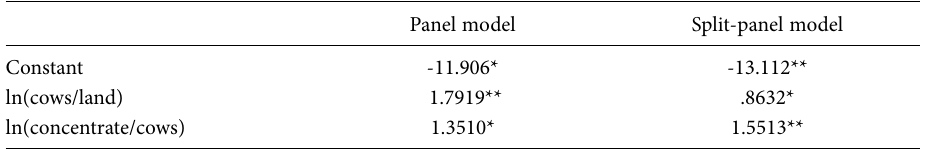
Table 2. Prior probability equation for the intensive